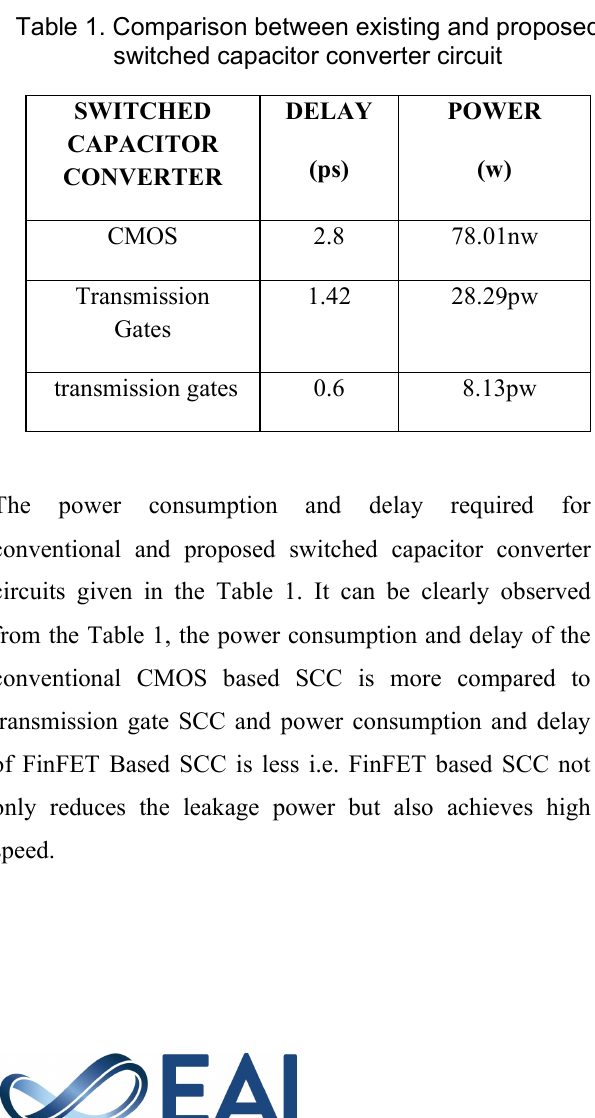
Table 1. Comparison between existing and proposed